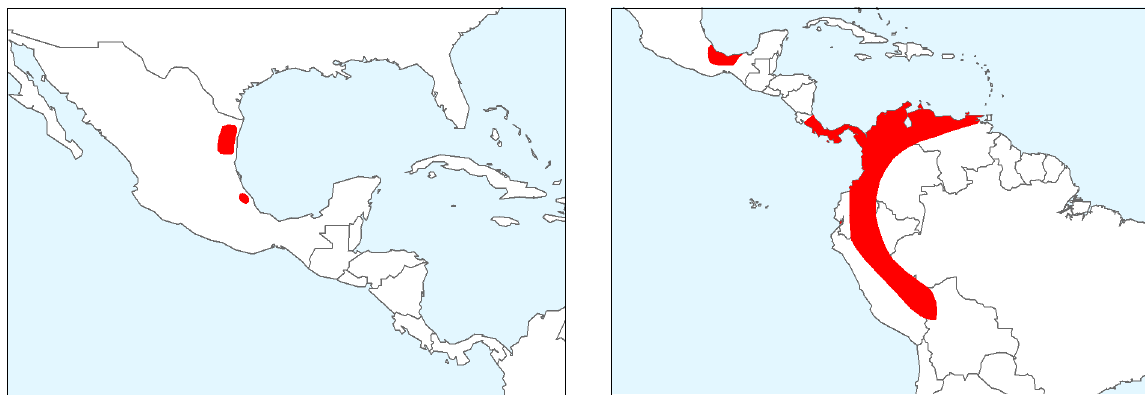
Fig. 6. Discontinuous mainland ranges. Native range of Dioon edule made of two separated fragment ranges (left). Taxonomic complex comprising possibly of two taxa: Monstera lechleriana (right)